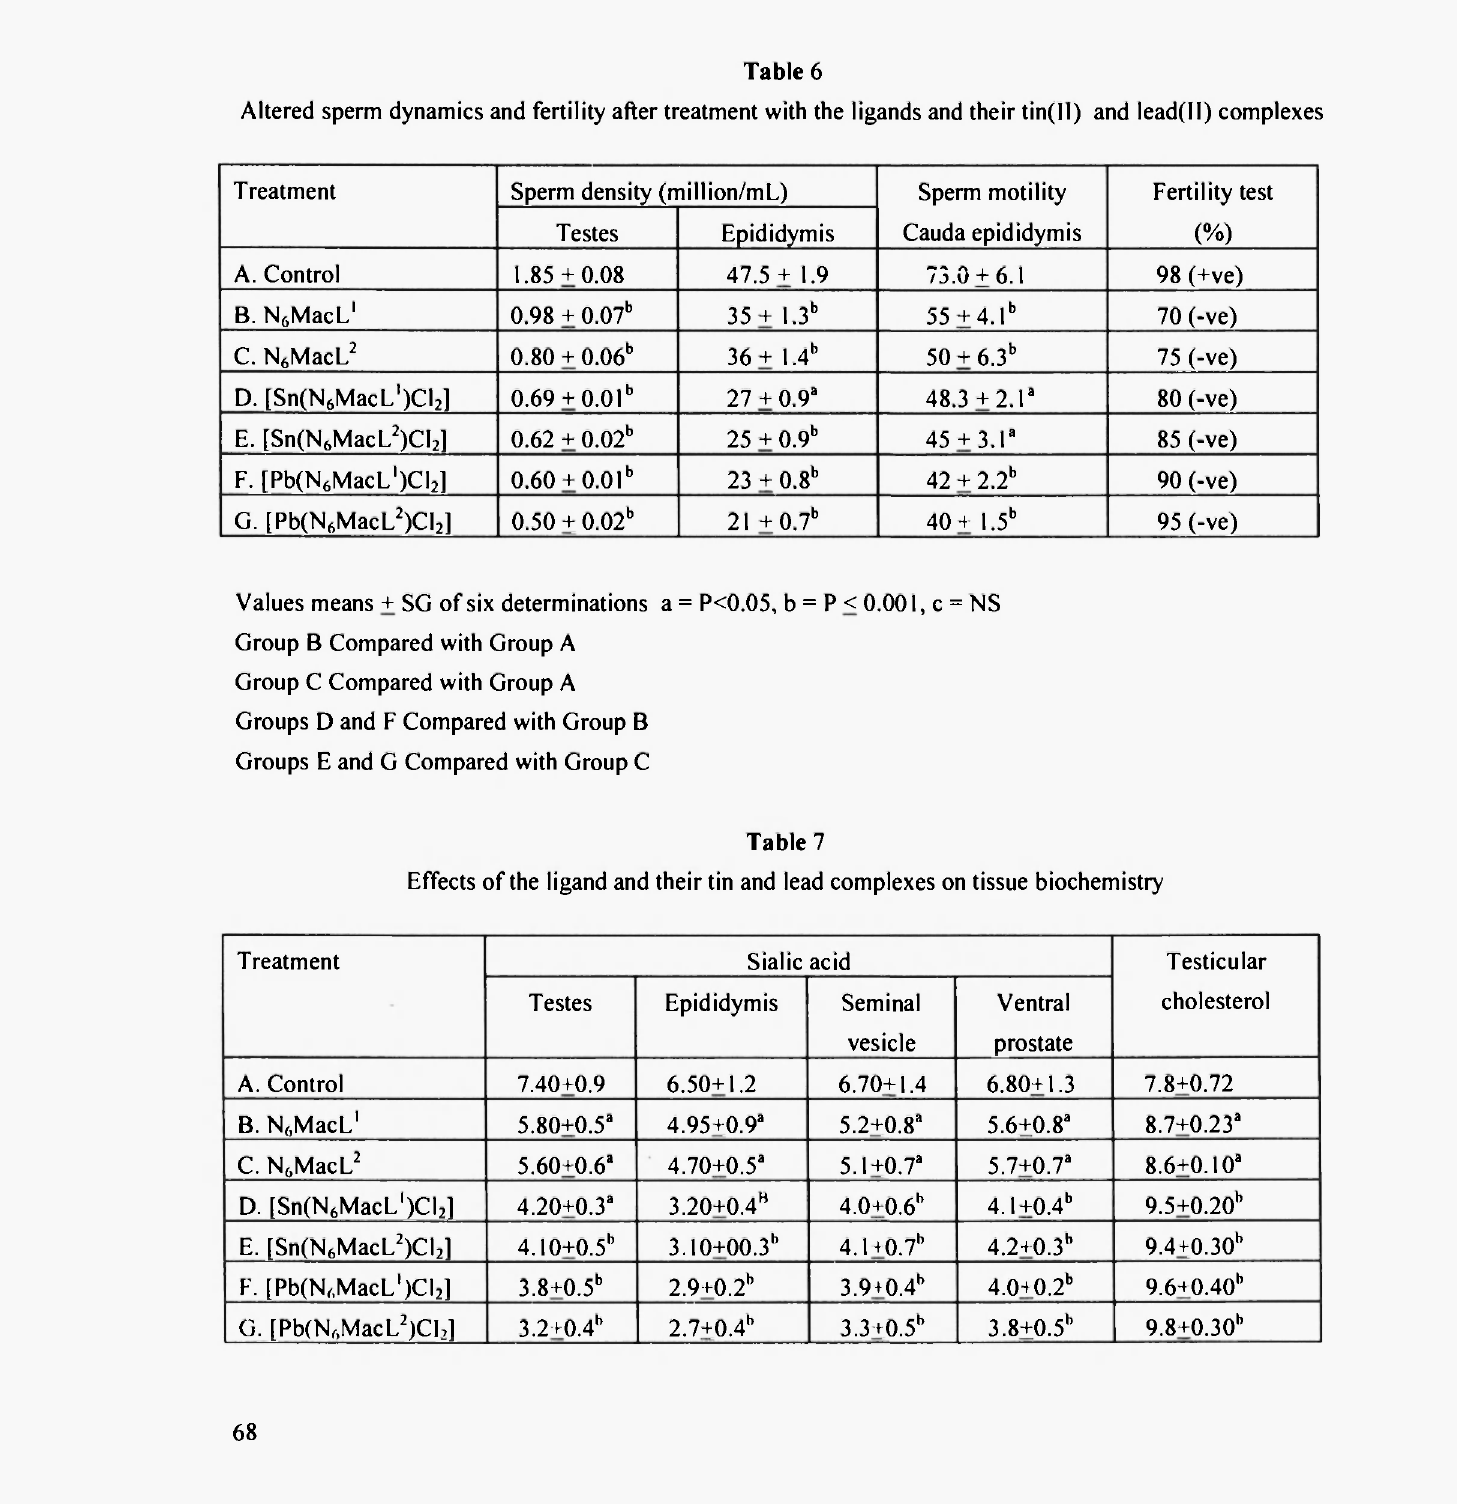
Altered sperm dynamics and fertility after treatment with the ligands and their tin(Il) and lead(II) complexes